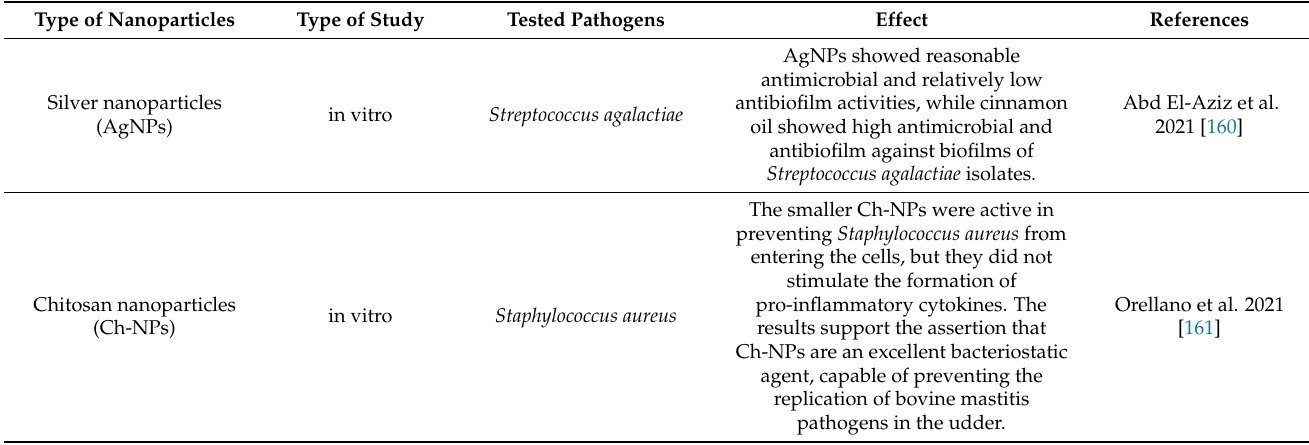
Table 2. Summary of recent studies regarding the use of nanoparticles against bovine mastitis